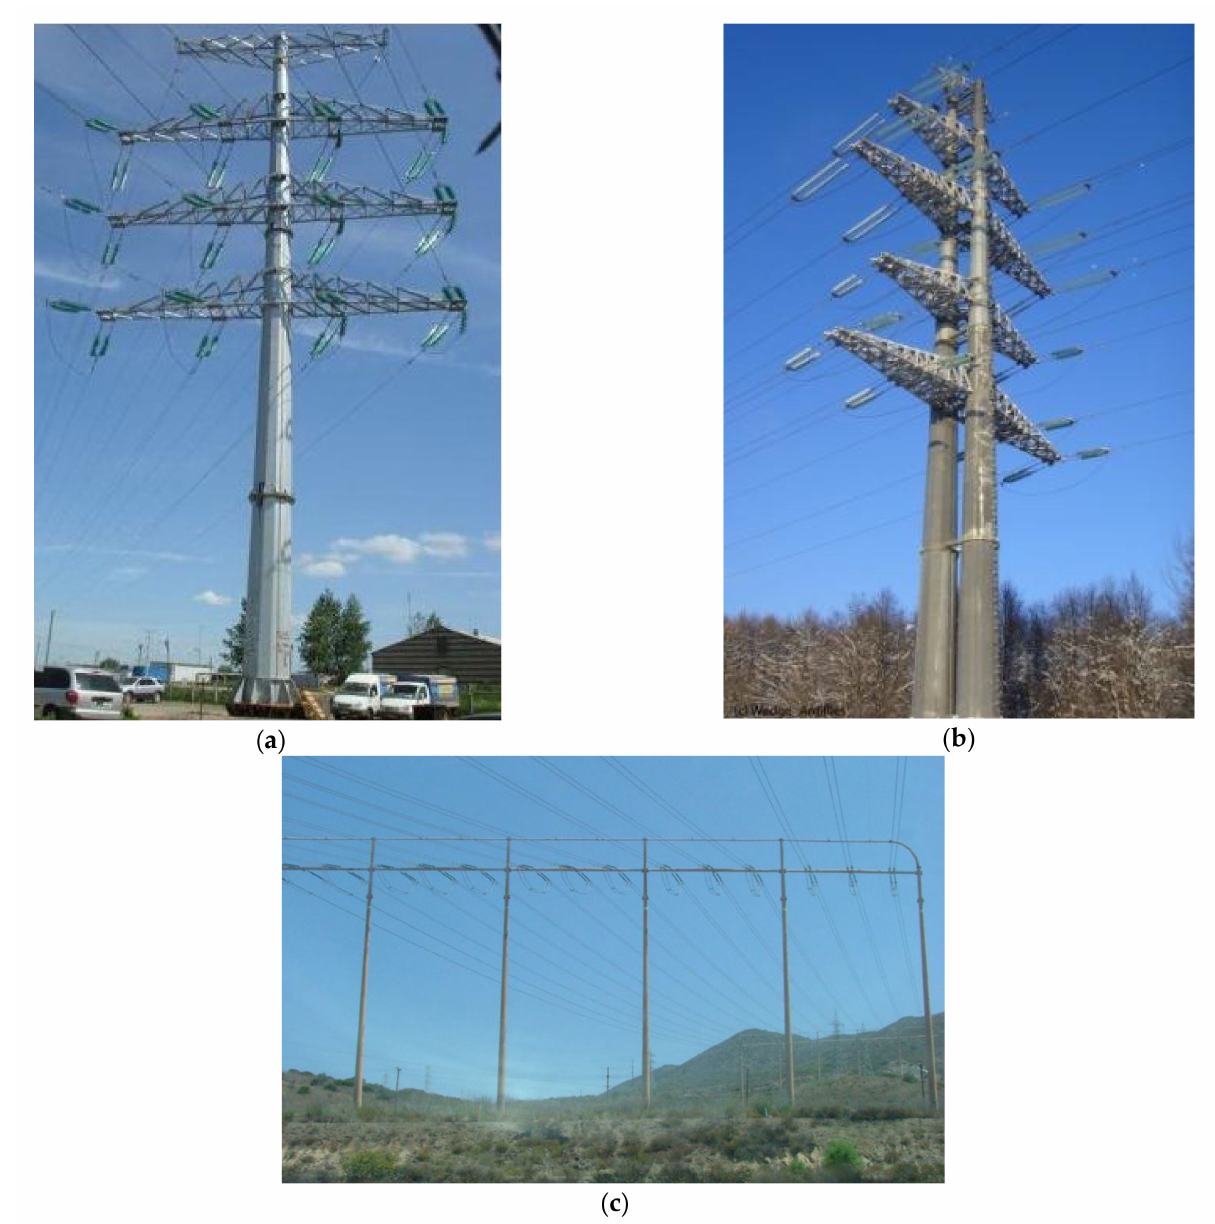
Figure 3. Towers of high-voltage